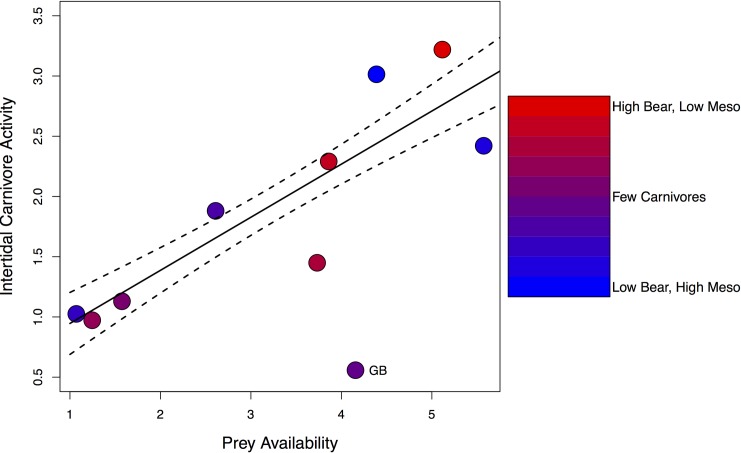
Relationship between intertidal prey availability and the overall activity of intertidal foraging carnivores (bears and mesocarnivores) in Clayoquot.Prey availability and intertidal carnivore activity are scaled metrics of prey abundance and carnivore relative abundance, respectively, and thus do not have units (see Methods for details on calculating these metrics). Coloring of points reflects site-level scores for the first principal component of a PCA describing carnivore community structure, where high values (red) represent bear dominated sites, low values (blue) represent mesocarnivore dominated sites, and middling values (mid-spectrum colors) represent sites with mixed, but relatively low carnivore abundance (see also S1 Fig). Solid and dashed lines represent linear regression estimates (± SE) of the relationship between prey availability and intertidal carnivore activity. Grice Bay (GB) was excluded from this regression analysis, as described in the methods.